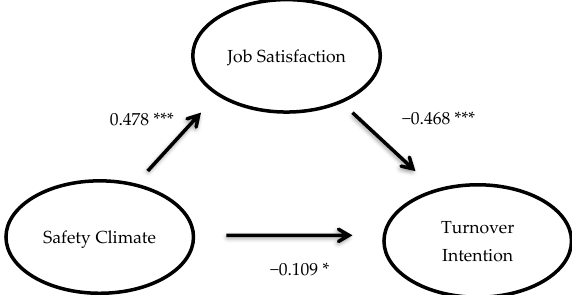
Figure 1. Path diagram illustrating the mediating role of job satisfaction on the association between safety climate and turnover intention. * p < 0.05; *** p < 0.001.